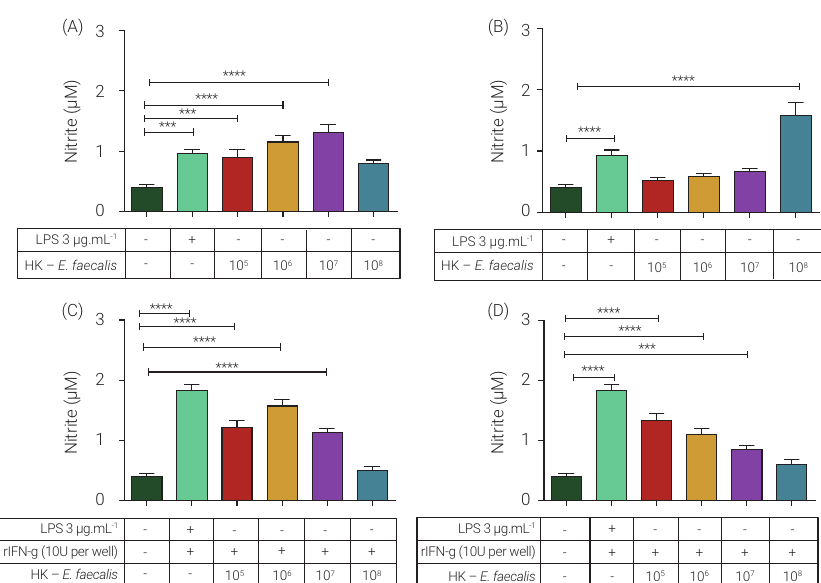
Figure 3. NO production by RAW 264.7 cells. Graphs represent values of sodium nitrite with different concentrations (10 5 -10 8 CFU.mL -1 ) of HK- S. aureus antigen (A) with rIFN-γ (C) or HK- E. faecalis antigen (B) with rIFN-γ (D), after 72h of cell incubation. Bars represent mean and standard error of sodium nitrite production in µM carried out in technical and biologic triplicates. Statistical differences by one-way ANOVA test and Bonferroni post hoc were represented by *** (p< 0.001) and **** (p < 0.0001).